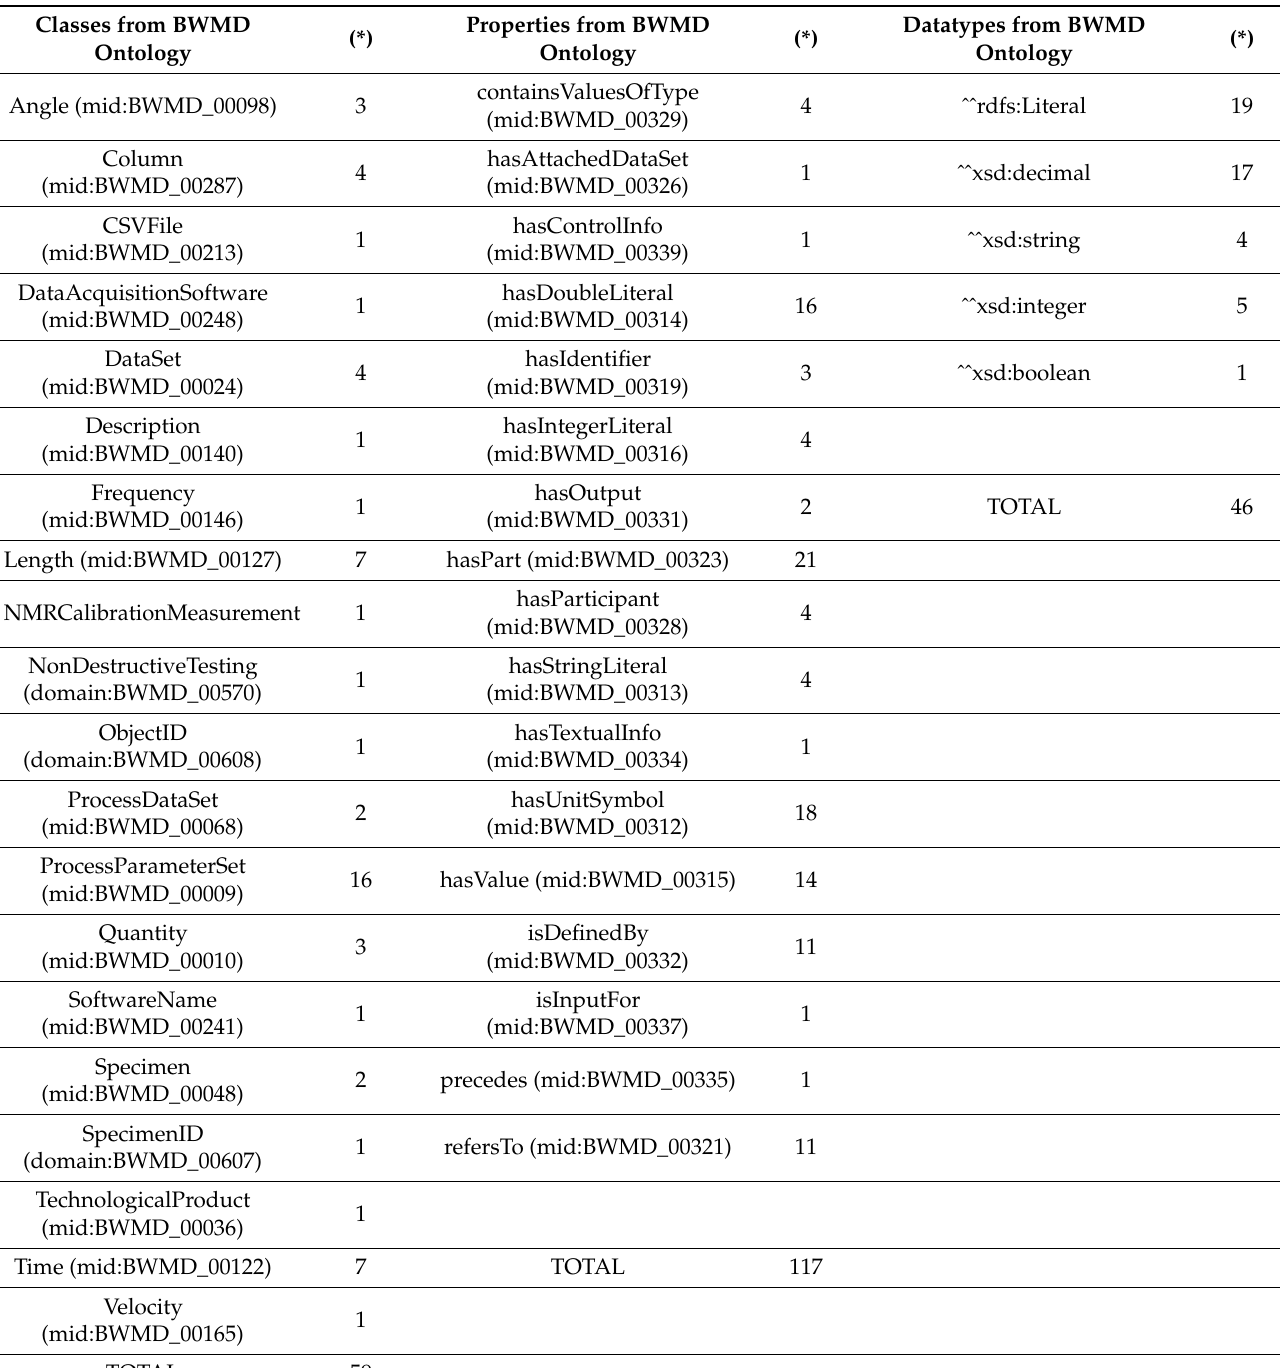
Table 1. Distribution of the instances needed to represent the 1 H NMR relaxometry test method. mid:BWMD_00XXX refers to a class or property from [101], and domain: BWMD_00YYY refers to a class or property from